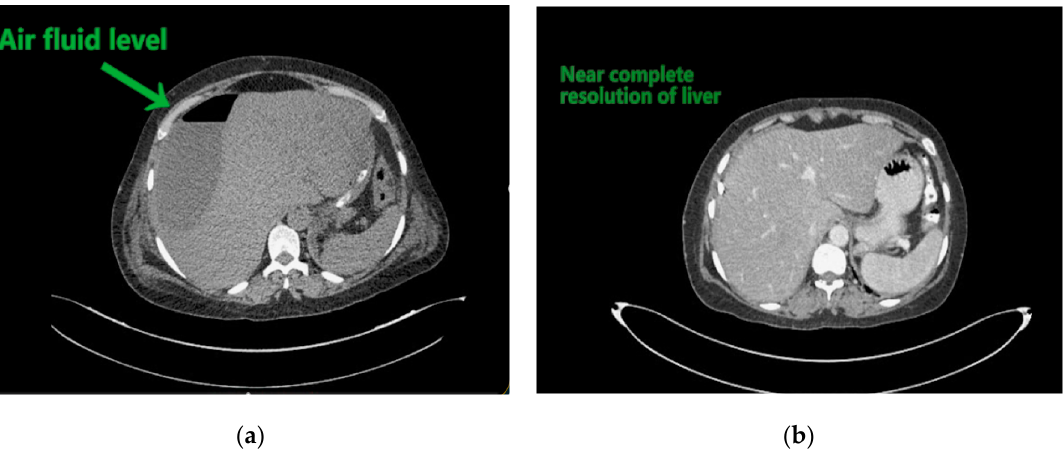
Figure 2. ( a ) Liver abscess showing air fluid levels; ( b ) showing resolution after 10 days. The patient underwent ultrasound guided percutaneous abscess drainage and place- ment of 12-Fr and 14-Fr catheter in liver and pelvic collections respectively. The aspirate was purulent and Klebsiella pneumoniae was detected in cultures. Blood culture was nega- tive even on repeated samples. Gene xpert (CB NAAT) was negative for mycobacterium tuberculosis (MTB). Fluid samples were also negative for malignant cells. She was started on antibiotics Piperacillin and tazobactum combination and monitored for blood glucose levels as a high suspicion of diabetes. Antibiotics was switched to imipenem as per the sensitivity of fluid cultures. She was tested negative for human immunodeficiency virus (HIV). Conservative management was continued as the patient improved with a repeat CECT after 10 days showing complete resolution of liver abscess and 30–40 cc